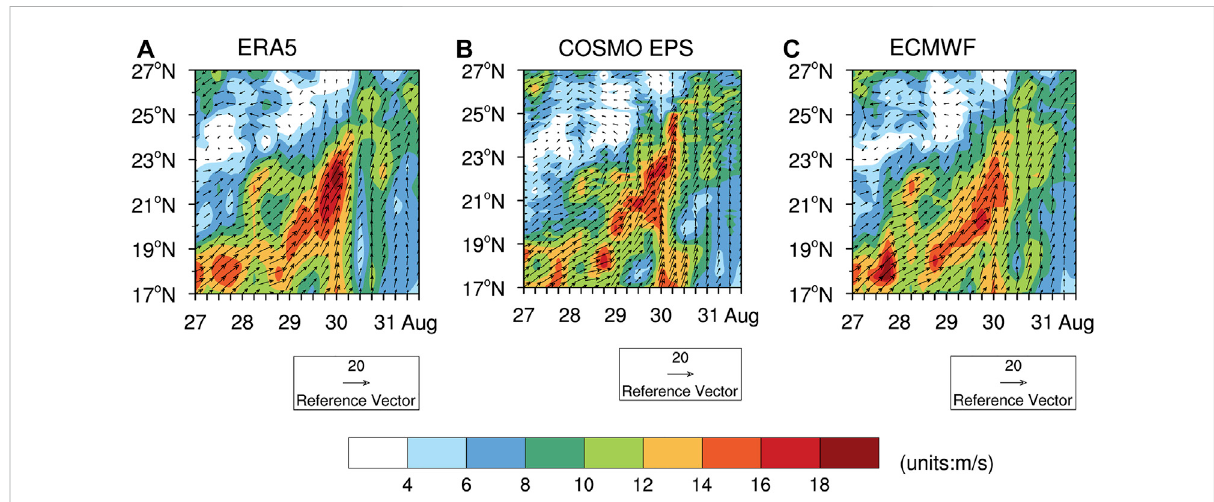
FIGURE 8 Time-latitude cross sections of 850 hPa wind (vector, unit: m · s − 1 , wind speed greater than 4 m s − 1 is shaded) along 113 ° E from 00 UTC on 27Augustto18UTCon31August2018for (A) theobservations, (B) theensemblemedianforecastofCOSMOEPS,and (C) thedeterministicforecast of